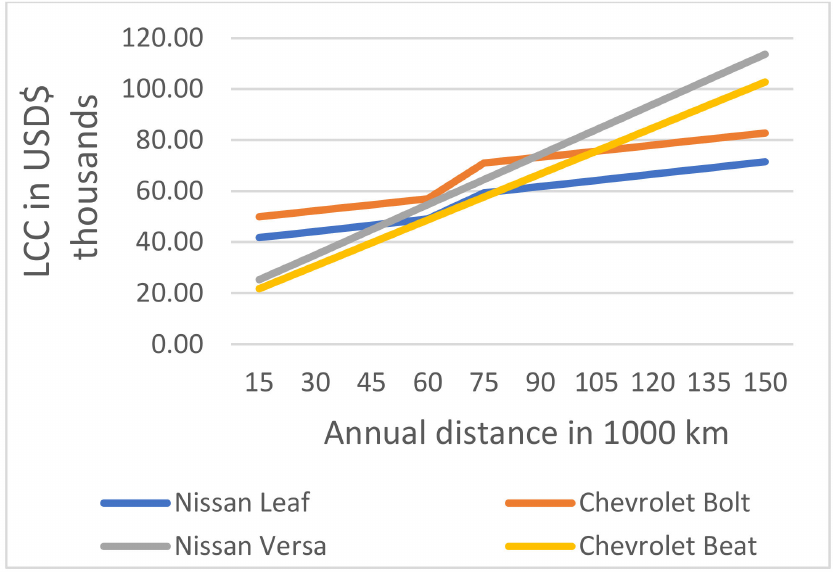
Figure 5. LCC with different annual distances traveled.